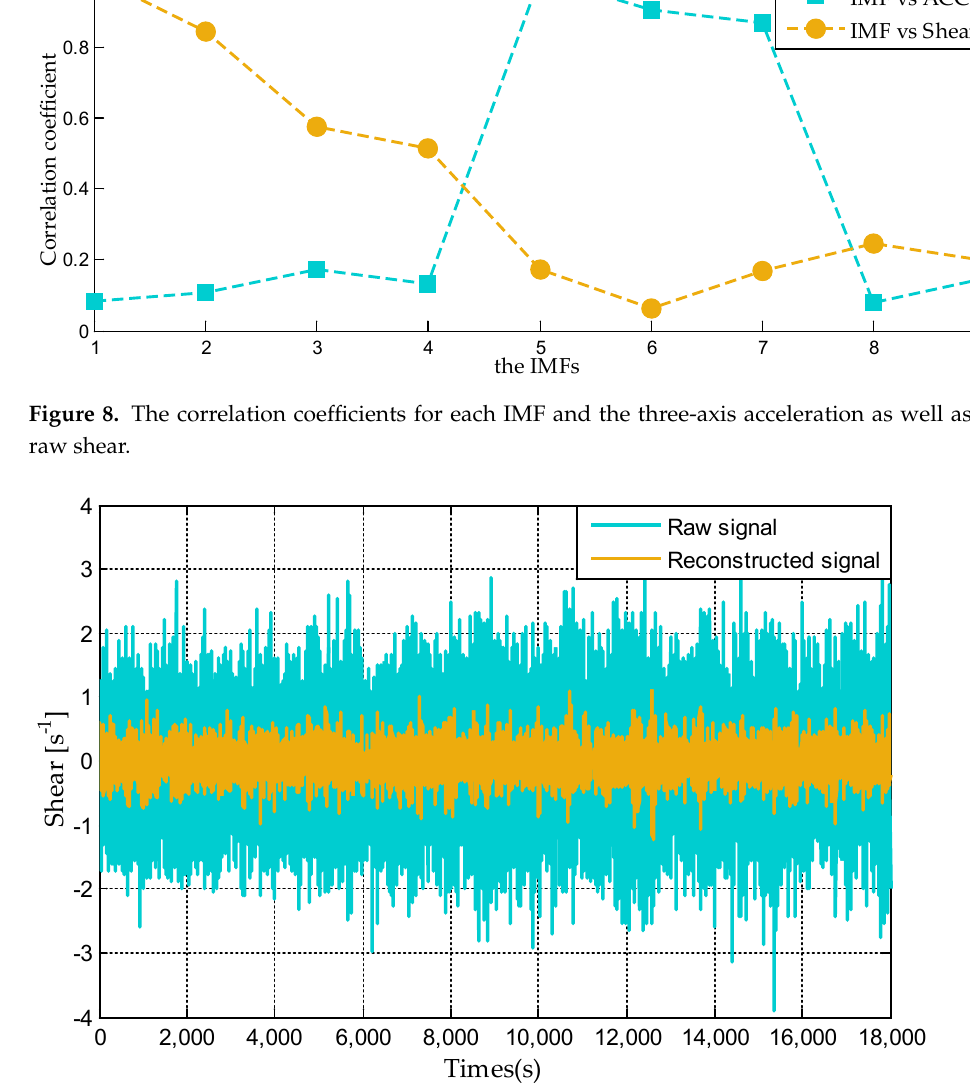
Figure 9. The comparison of the reconstructed shear and raw shear signal in time domain.